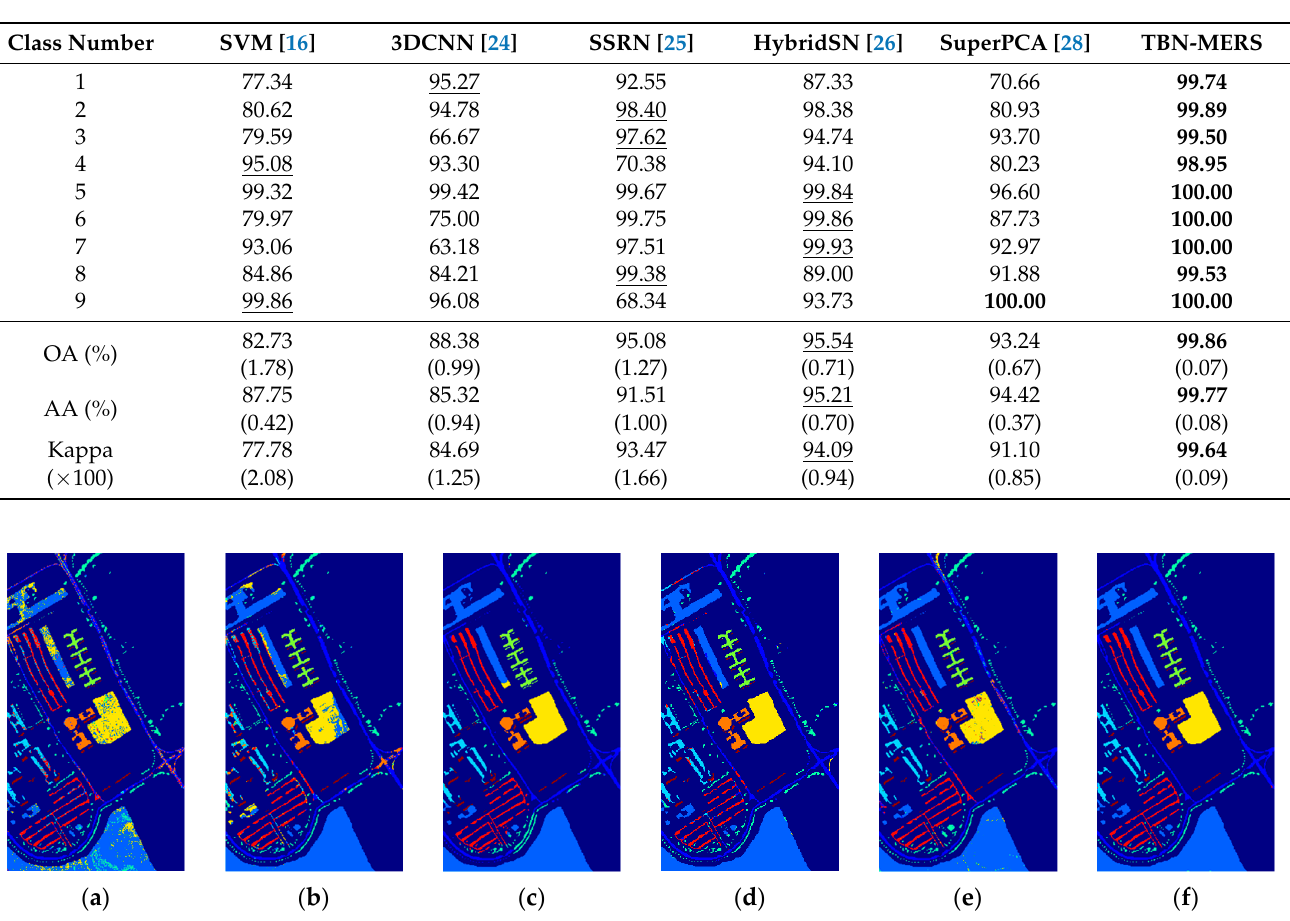
Table 11. Classification results of different methods on PU with 50 samples per class.